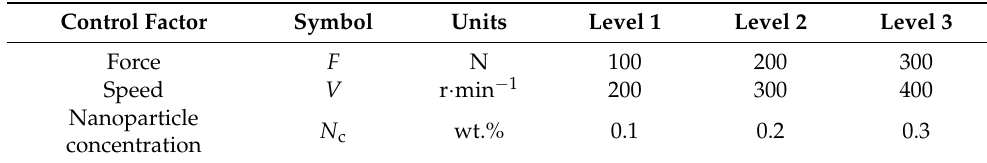
Table 4. Control factors and the corresponding levels.